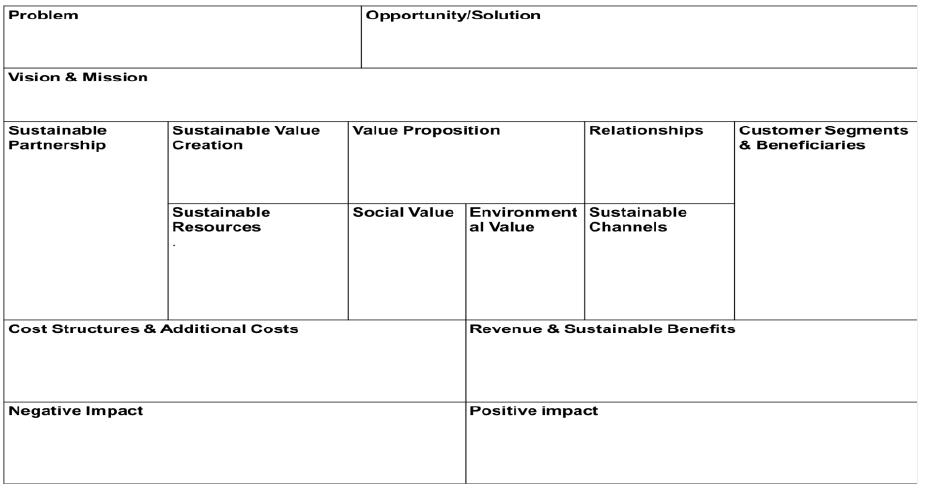
Figure 2: A business model template; Source: